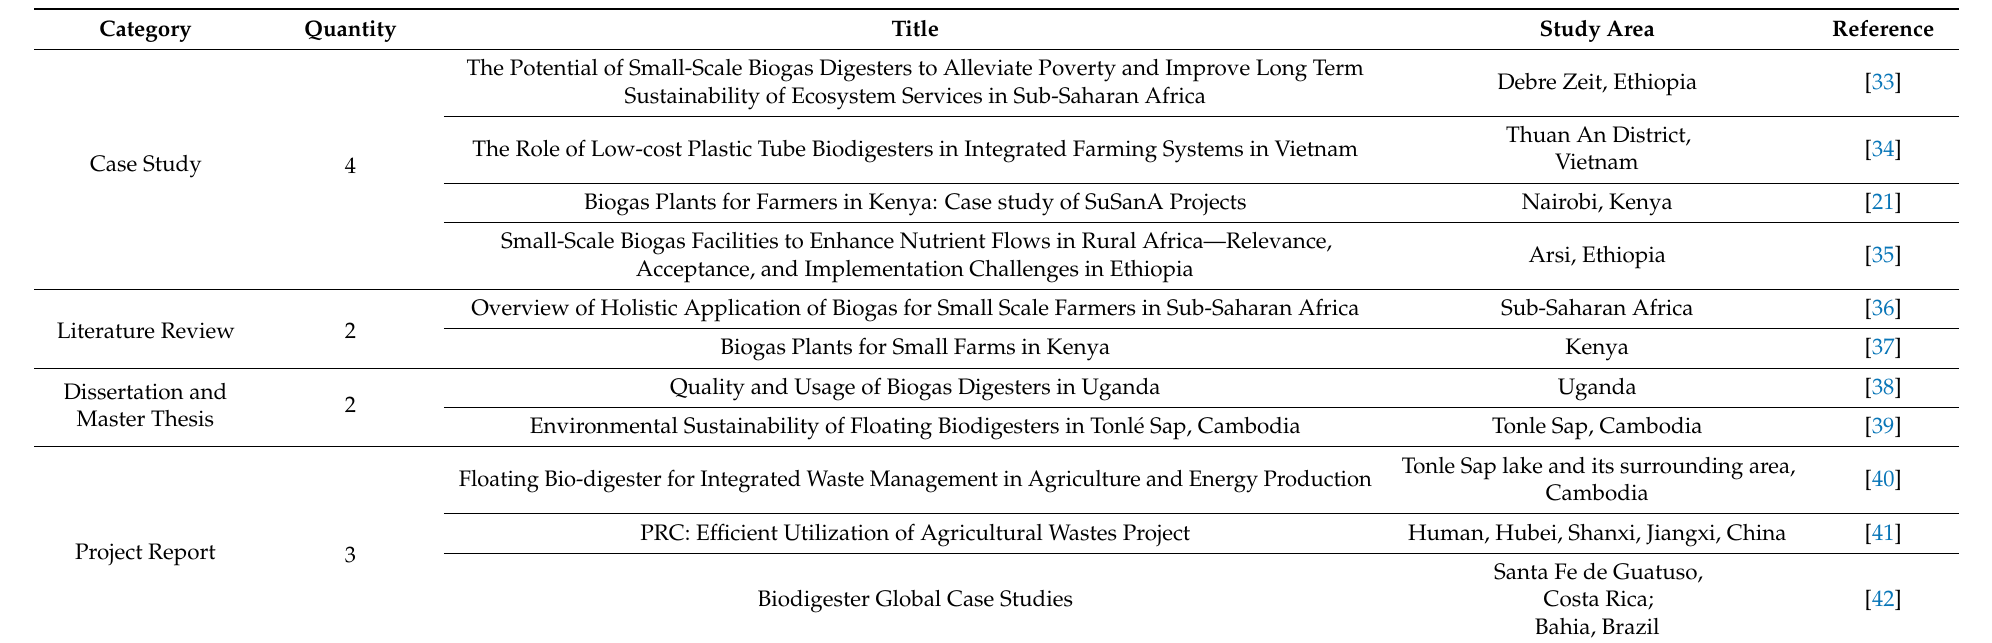
Table 1. Summary of the 11 cases considered for the